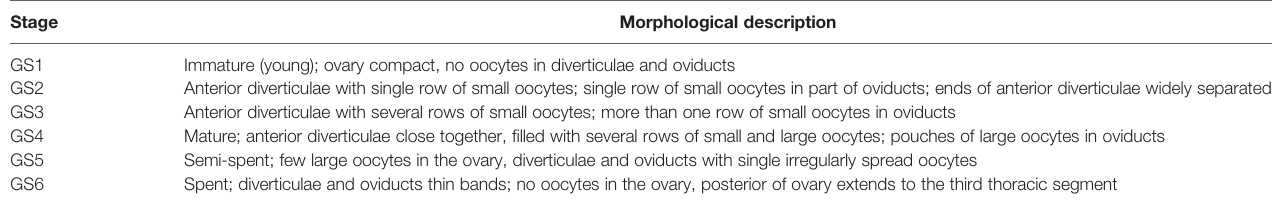
TABLE 2 | Gonad maturation stages (GS) of Calanus adult females. Stage Morphological description GS1 Immature (young); ovary compact, no oocytes in diverticulae and oviducts GS2 Anterior diverticulae with single row of small oocytes; single row of small oocytes in part of oviducts; ends of anterior diverticulae widely separated GS3 Anterior diverticulae with several rows of small oocytes; more than one row of small oocytes in oviducts GS4 Mature; anterior diverticulae close together, fi lled with several rows of small and large oocytes; pouches of large oocytes in oviducts GS5 Semi-spent; few large oocytes in the ovary, diverticulae and oviducts with single irregularly spread oocytes GS6 Spent; diverticulae and oviducts thin bands; no oocytes in the ovary, posterior of ovary extends to the third thoracic segment GS, states of gonadal